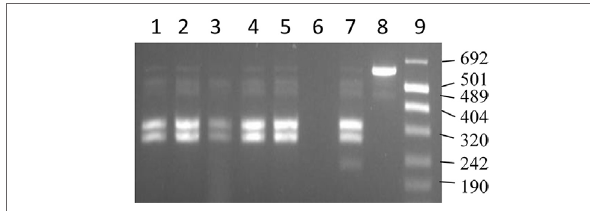
FigUre 4 | IS 1311 PCR-restriction endonuclease analysis profiles for DNA extracted from tissues. Lanes 1, 2, and 4 are IS 1311 PCR products from DNA extracted from gut tissues restricted with Mse I and Hinf I enzymes. Lanes 3 and 5 are IS 1311 PCR products from DNA extracted from lymph node tissues restricted with Mse I and Hinf I enzymes. Lane 6 is negative control. Lane 7 is IS 1311 PCR product from S strain restricted with Mse I and Hinf I enzymes. Lane 8 is the unrestricted IS 1311 PCR product from S strain. Lane 9 is the molecular size markers (Number